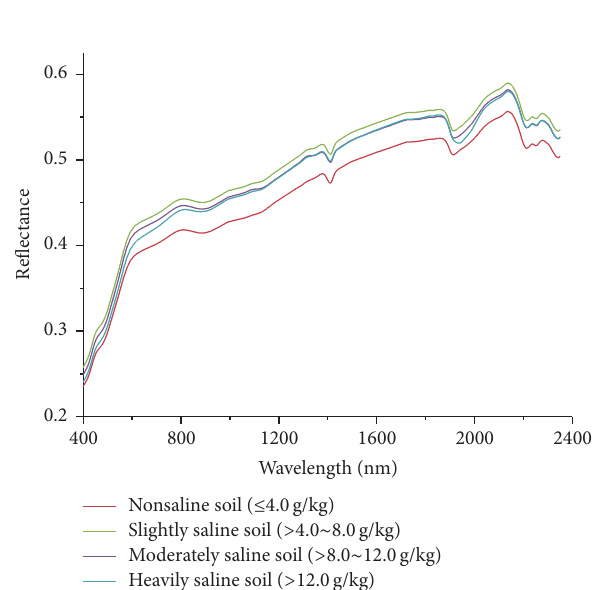
Figure 3: Spectral curves of soils with different degrees of saliniza-